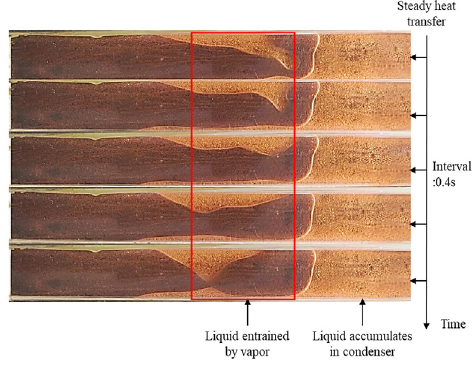
Figure 16. Vapor–liquid entrainment phenomenon [81].